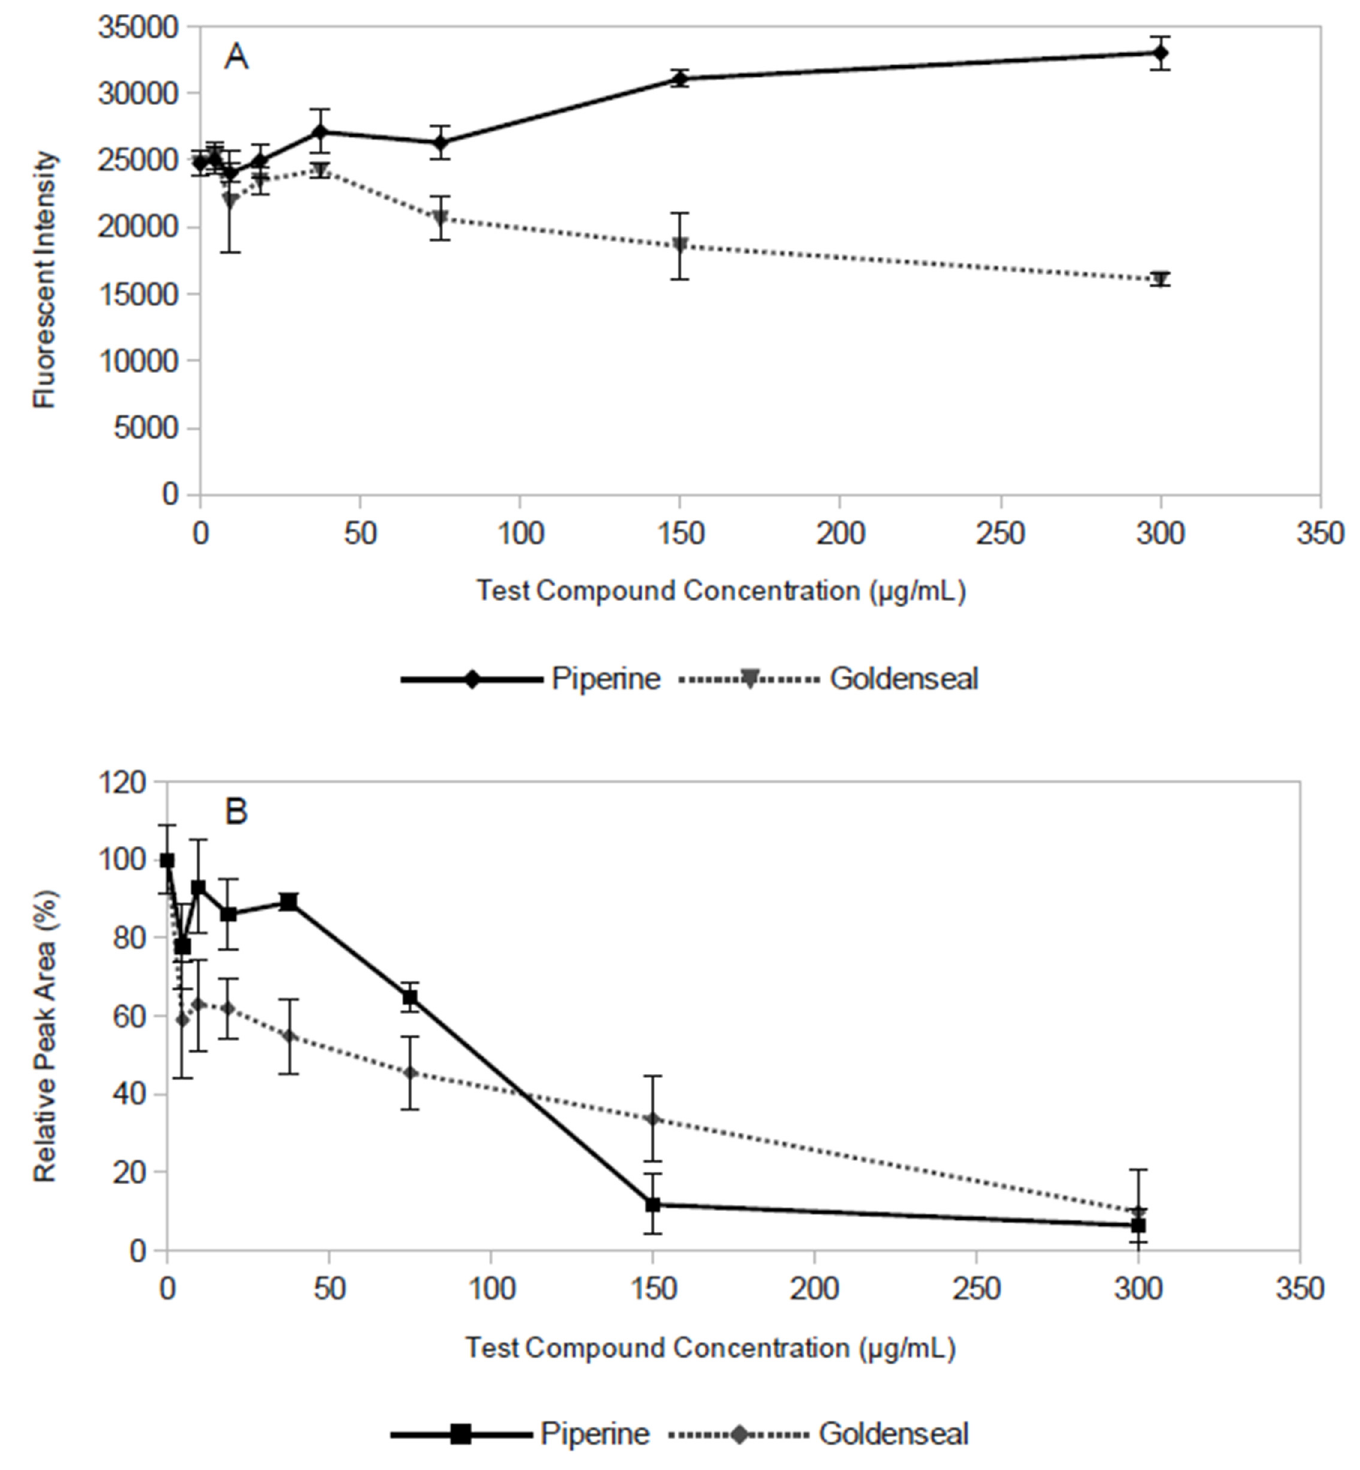
Fig 5. Efflux pump inhibition in S . aureus by a goldenseal ( Hydrastis canadensis ) extract. (A) Data collected using the fluorescence-based ethidium accumulation assay for a range of H . canadensis extract concentrations. (B) Data collected using the mass spectrometry-based ethidium accumulation assay. Incubation time was 30 min for both A and B, data represents mean of 3 samples, error bars represent standard deviation.